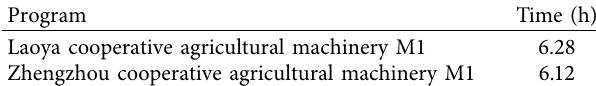
Table 6: Scheme comparison